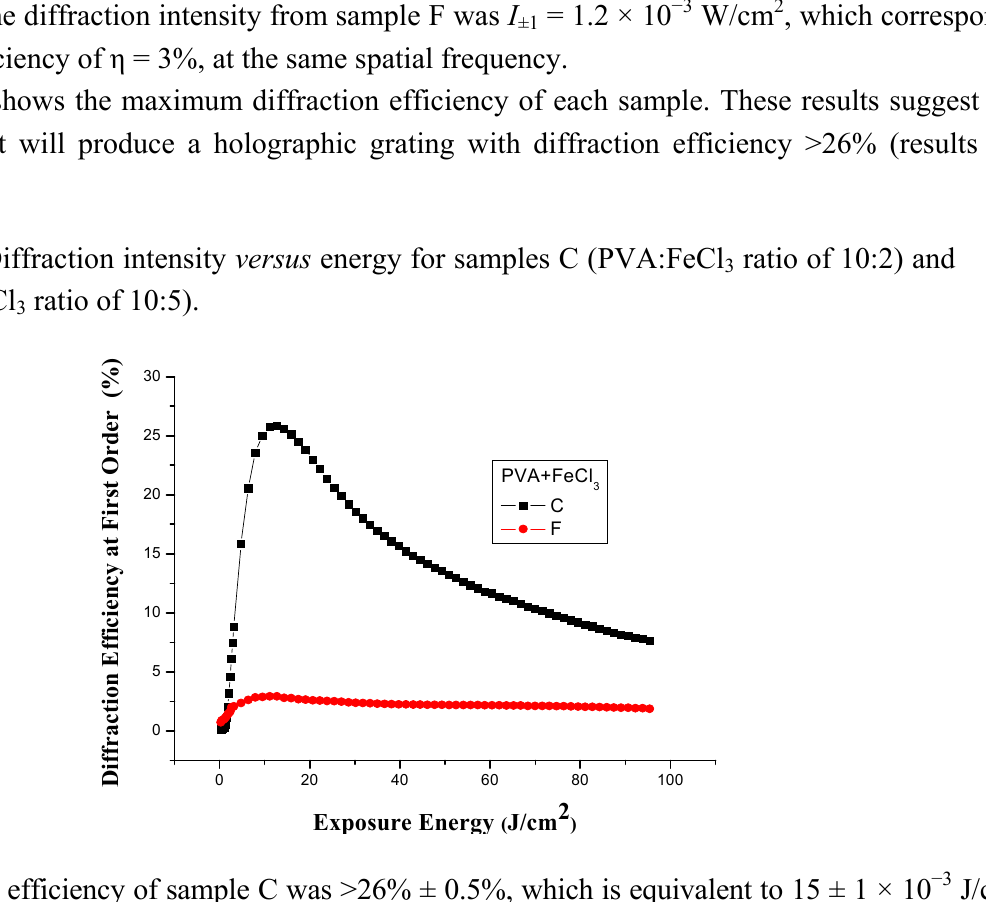
ratio of 10:2) and 3